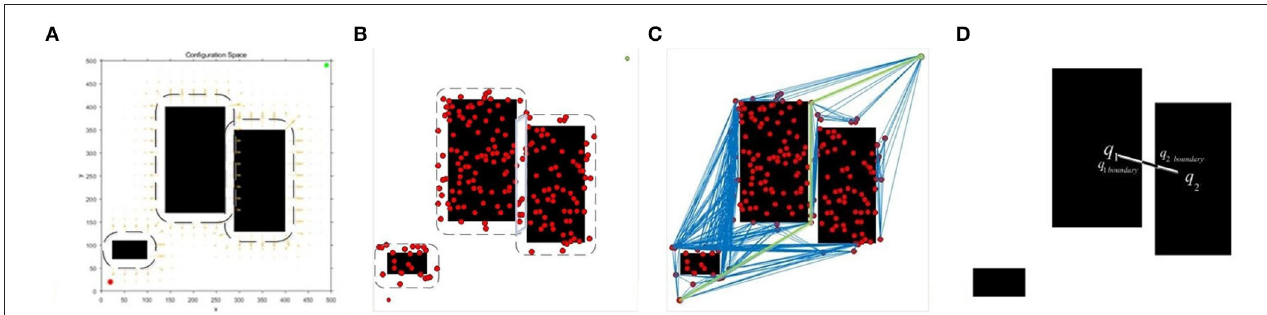
FIGURE 3 | Sampling strategy based on the obstacle potential field: (A) Obstacle potential field; (B) Target sampling result; (C) Random roadmap; (D) Narrow corridor width calculation.